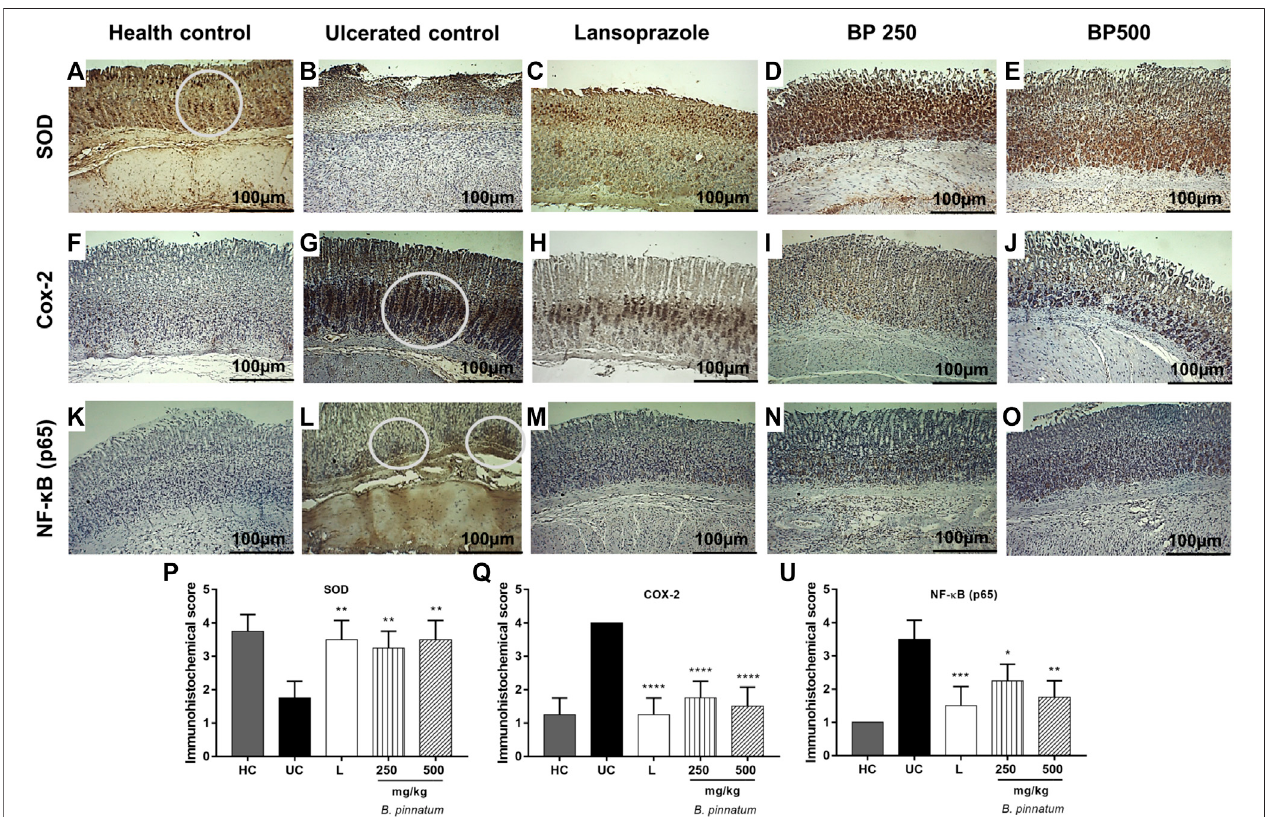
FIGURE9| ImmunohistochemicalanalysisofSOD,COX-2, andNF- κ B(p65)inratgastrictissue,showingthecutofthestomachinthetransverse direction. (A – K) Healthy control; (B – L) ulcerated control; (C – M) lansoprazole; (D – N) B. pinnatum 250 mg/kg; (E – O) B. pinnatum 500 mg/kg; (P) SOD immunohistochemical score; (Q) COX-2 immunohistochemical score; (U) NF- κ B (p65) immunohistochemical score. The circle indicates strong brown region. Data expressed as mean ± standard mean error ( n (cid:2) 5). Mann – Whitney used to calculate statistical signi fi cance, * p < 0.05, ** p < 0.01, *** p < 0.001, **** p < 0.0001 vs. ulcerated control. Healthy control, HC; ulcerated control, UC; lansoprazole,